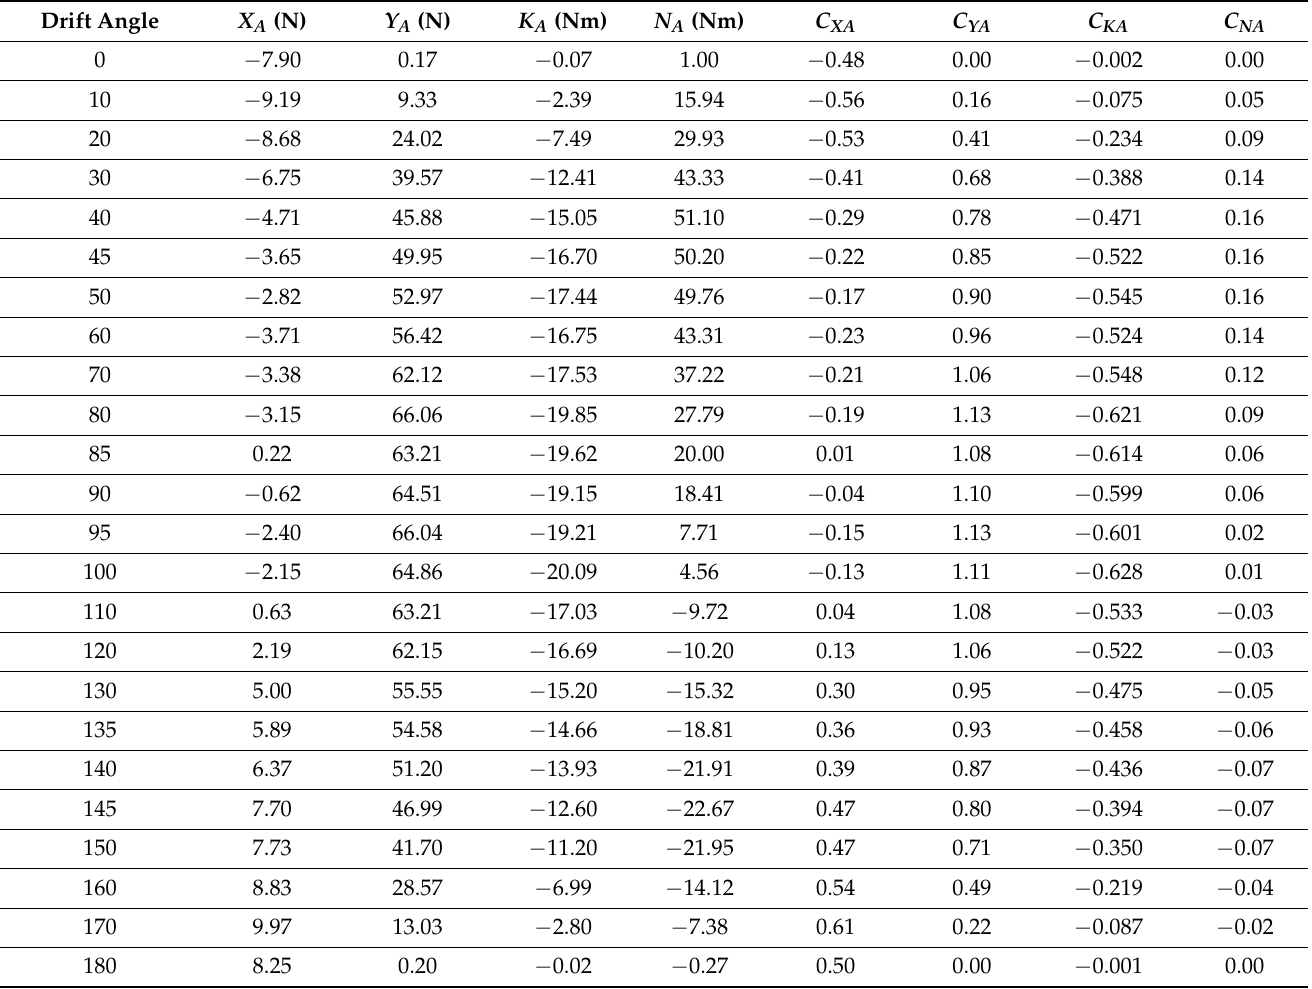
Table 4. The computed aerodynamic forces/moments in the model scale and their coefficients.